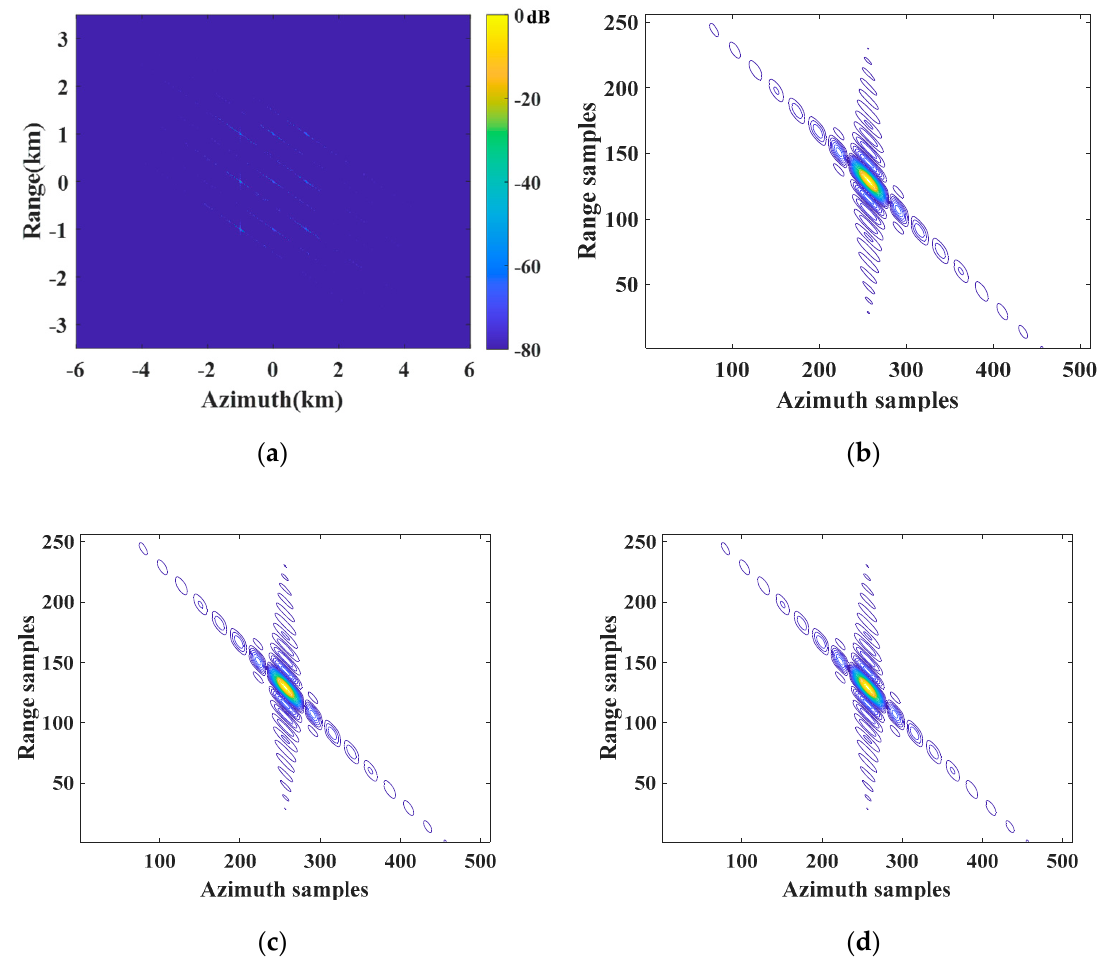
Figure 16. Imaging results on the designed scene with nine point targets handled by the proposed multichannel reconstruction approach based on AHRE. ( a ) The designed scene imaging result; ( b ) contour plots of P1; ( c ) contour plots of P2; ( d ) contour plots of P3. Table 2. The measured focusing parameters of simulated point targets in Figure 15 and Figure 16.